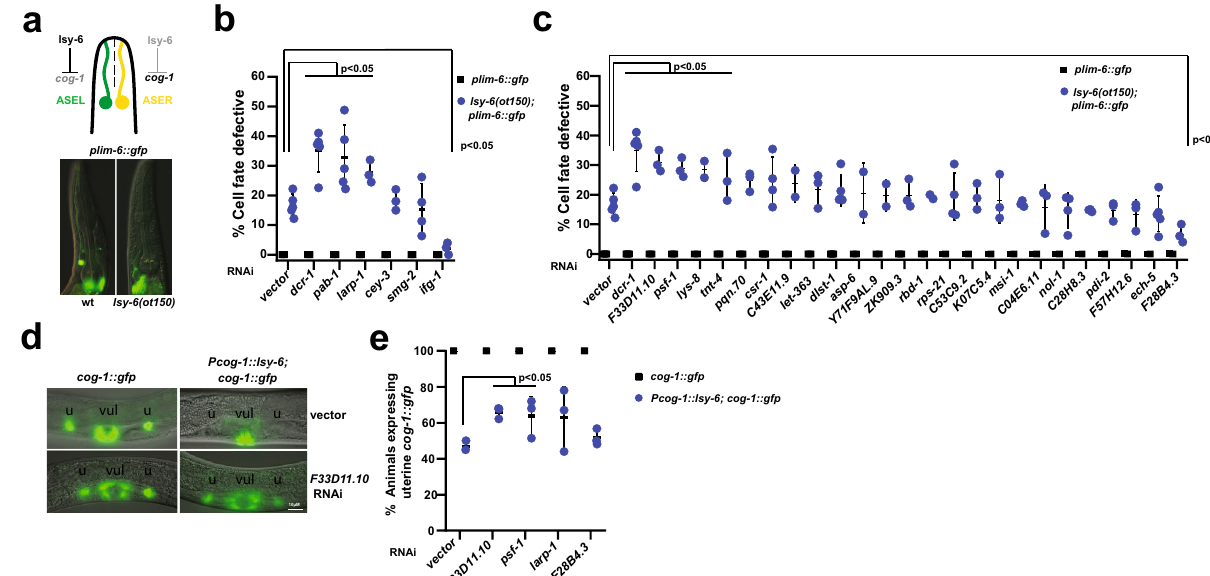
Figure 5. ALG-1 and miRNA interactors genetically interact with lsy-6(ot150) . ( a ) lsy-6 determines the asymmetric expression of chemoreceptors in ASER and ASEL neurons, with plim-6::gfp expression marking ASEL neuronal cell fate. ASEL cell defective phenotype in the lsy-6(ot150) animals can be observed by lack of plim-6::gfp expression some of the time (quantified in b). RNAi knockdown of ( b ) conserved AGO 19 and ( c ) miRNA/ALG-1 interactors in plim-6::gfp or lsy-6(ot150); plim-6::gfp animals . Each dot represents an independent RNAi experiment. Statistical significance was determined by One-way ANOVA with post hoc Bonferroni correction. ( d ) cog-1 expression in uterine cells is repressed by pcog-1::lsy-6 . RNAi of F33D11.10 depresses cog-1::gfp in that background (quantified in e). ( e ) RNAi of genes that modify lsy-6(ot150) phenotype alleviates lsy-6-mediated repression of cog-1::gfp in uterine cells. Each dot represents an independent RNAi experiment. T-test was used to determine statistical significance. Vector = empty vector RNAi